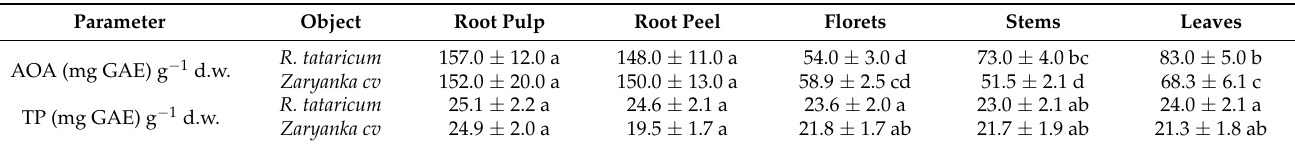
Table 1. Total antioxidant activity and polyphenols accumulation by R. tataricum and garden rhubarb, cultivar Zaryanka, using ethanolic extracts of tissues.